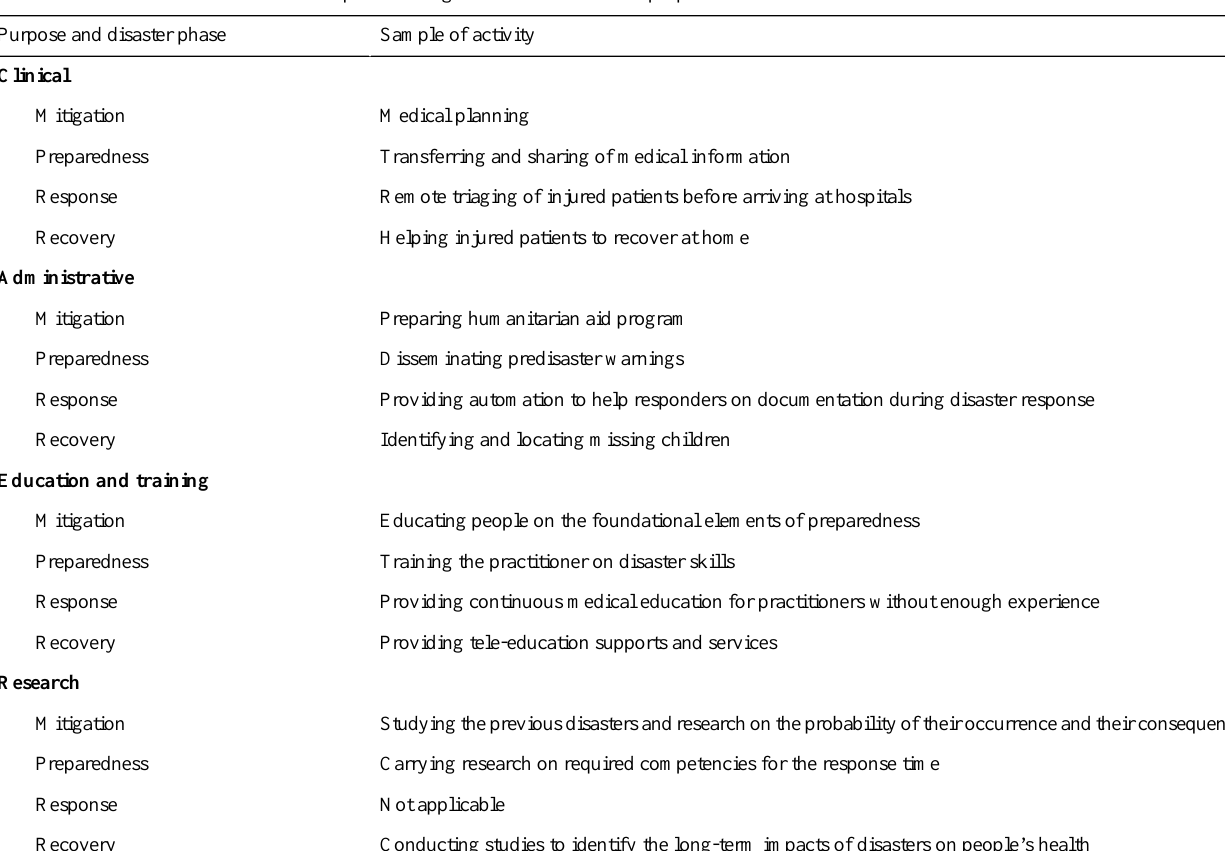
Table 2. Disaster eHealth activities examples with regard to disaster eHealth